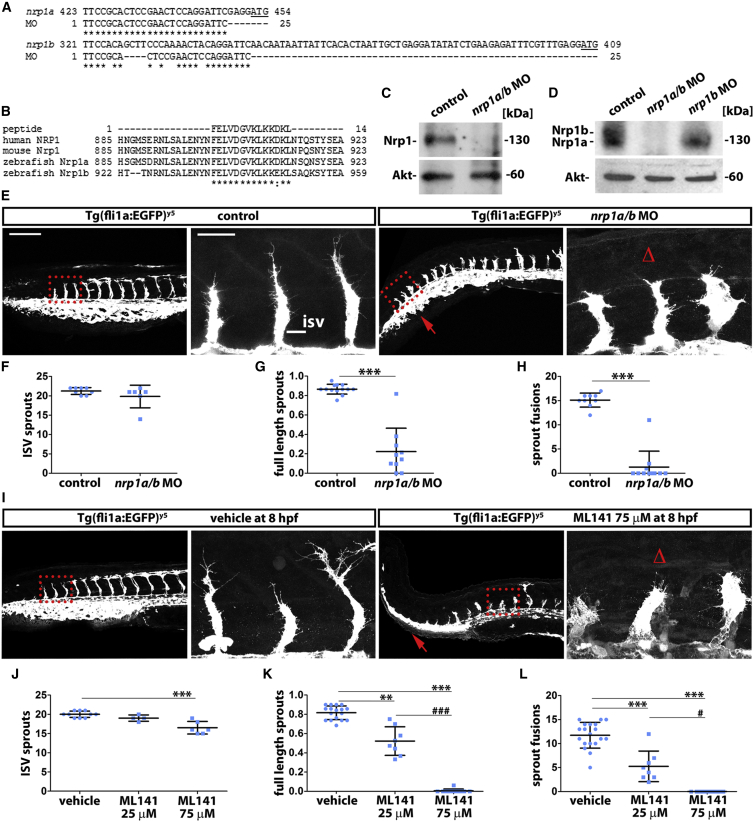
Vessel Sprouting Is Compromised by Nrp1 Knockdown or Cdc42 Inhibition in Zebrafish(A) Alignment of the nrp1a/b MO nucleotide target sequence with the 5′ UTR immediately upstream of the start codon (underlined) in nrp1a and nrp1b; asterisks indicate identical nucleotides.(B) Alignment of the peptide sequence recognized by anti-NRP1 antibody with the cytoplasmic tail of human and mouse NRP1 as well as zebrafish Nrp1a and Nrp1b; asterisks indicate identical amino acid residues, and the colon indicates a conservative substitution.(C and D) Protein lysates from control and nrp1a/b and nrp1b MO-injected 32-hpf fish embryos were used for Nrp1 and Akt immunoblotting after electrophoresis using a 10% gel (C) or 4%–12% gradient gel (D).(E–L) Confocal z stacks of trunks from 32 hpf Tg(fli1a:EGFP)y5 zebrafish and corresponding quantitation of the indicated vascular parameters for controls versus nrp1a/b MO (E–H) and vehicle versus ML141 treatment (I–L); scale bar, 200 μm. A kinked tail caused by Nrp1 knockdown is also seen after Cdc42 inhibition (red arrows). Boxed areas are shown at higher magnification adjacent to each corresponding panel to illustrate delayed sprout extension; scale bar, 25 μm. Δ indicates impaired sprout invasion into the dorsal trunk. The number of all ISV sprouts (F and J), full-length ISV sprouts (G and K), or ISV sprouts that have fused laterally (H and L) is shown as mean ± SD (n ≥ 4 fish for each treatment condition). Asterisks indicate p values for nrp1a/b MO or ML141 relative to controls ∗∗p < 0.01, ∗∗∗p < 0.001; hashtags indicate p values for 75 μM relative to 25 μM ML141 #p < 0.05, ###p < 0.001.